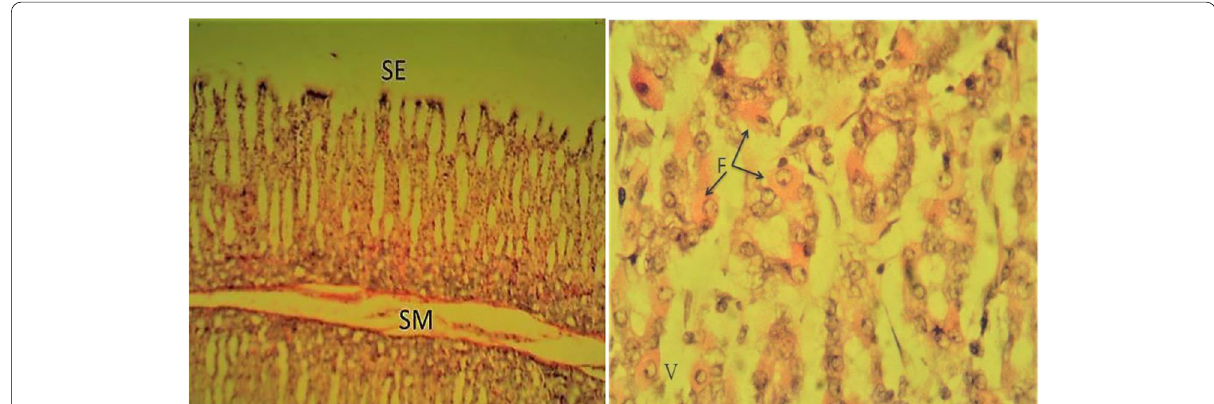
Fig. 8 Histological section of non-infected abomasum of sheep showing intact surface epithelium with goblet cells (SE), the sumbucosa (SM), pink staining normal parietal cells (F) with numberous chief cells nearby. (HE staining, 10x and 40x magnification)